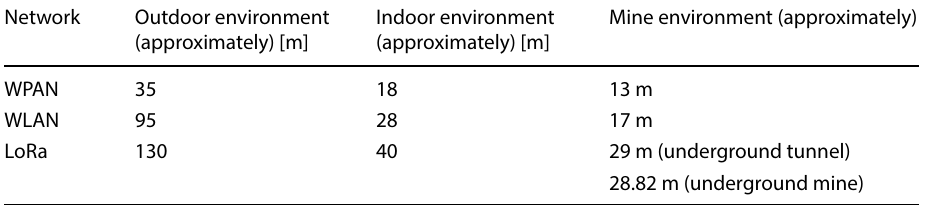
Table 8 Comparison of transmission range from different networks for different environments